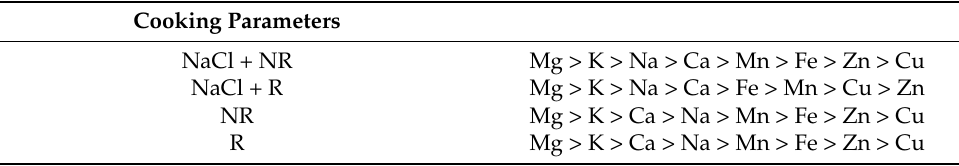
Table 7. Ranking of the content of minerals for each cooking